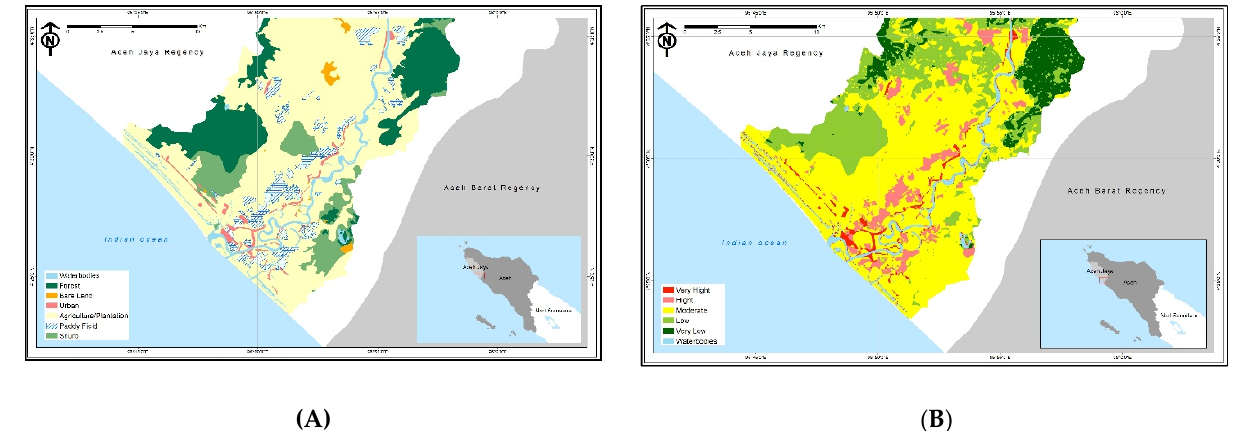
Figure 6. Land cover characteristics in relation to flood risk occurrence: ( A ) land use–land cover condition and ( B ) flood risk map.